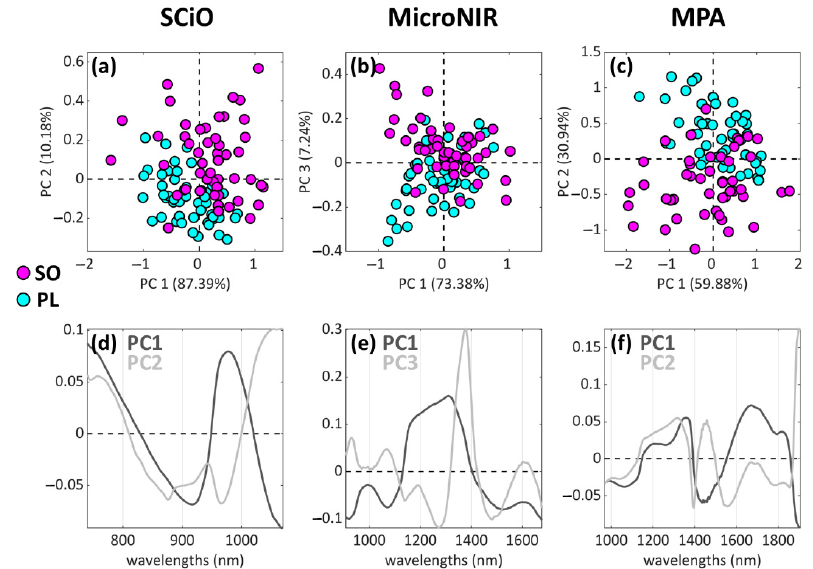
Figure 3. Most relevant PCA scores plots ( a – c ) in terms of SO-PL class separation, and the corre- sponding loadings plots ( d – f ). The three columns refer to, respectively, the ( a ) SCiO, ( b ) MicroNIR, and ( c ) MPA datasets. Table 2. Classification results: sole (SO) vs. plaice (PL), point of view for interpreting the values is the prediction of the SO class. All values are in percentage and those in bold score above 90%. SCiO